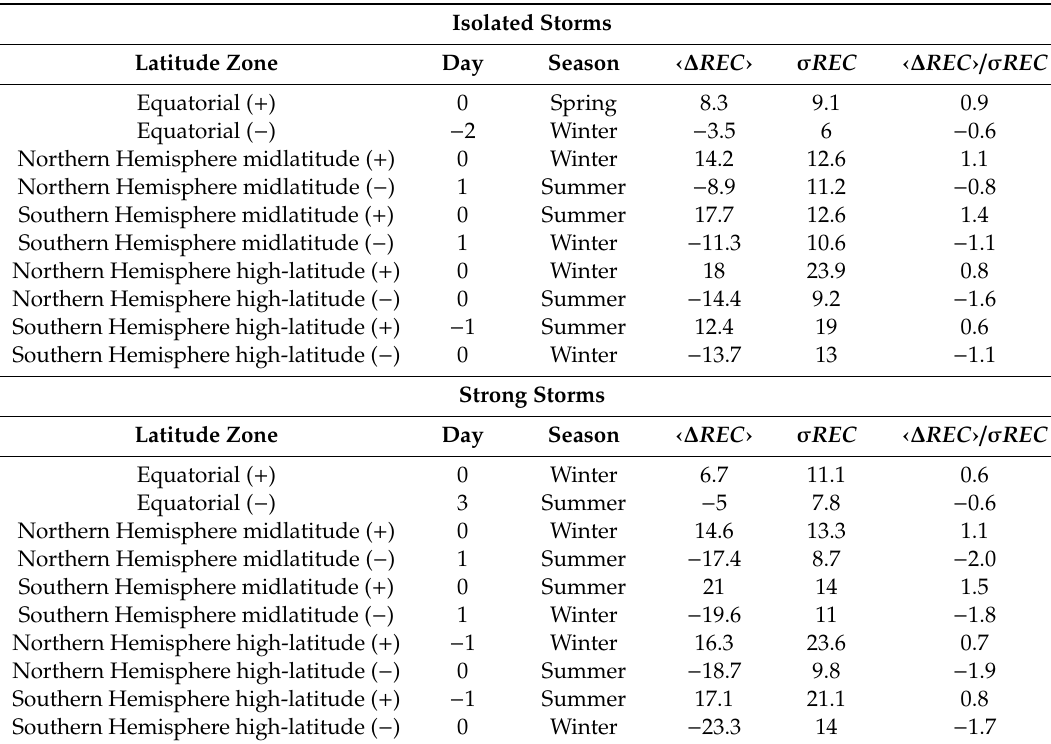
Table 3. Cases of highest signal-to-noise ratio for positive ( + ) and negative ( − ) responses in all latitudinal zones both for isolated and strong